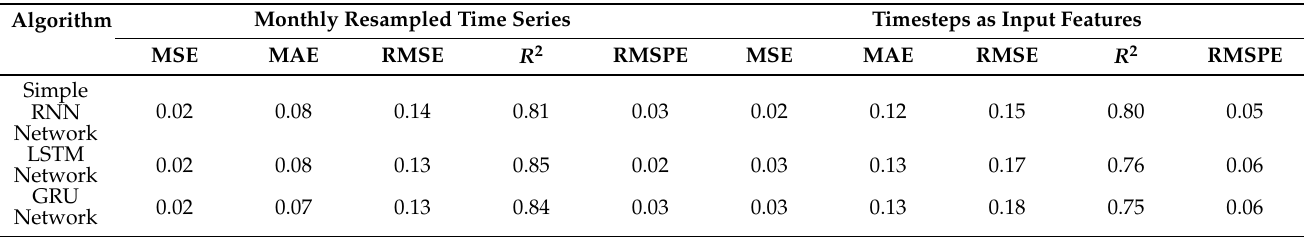
Table 9. Results when forecasting from all numerical OCT features, from three previous visits.